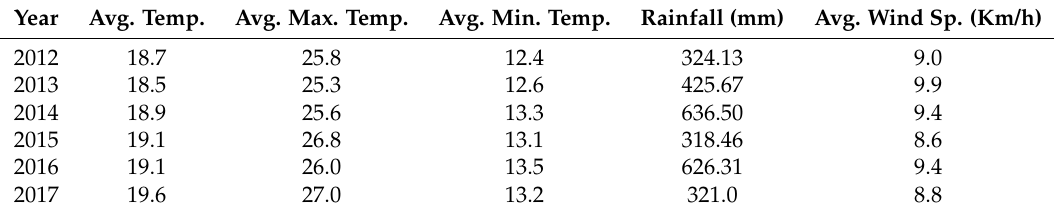
Table 2. Average temperatures, rainfall and average wind speed in